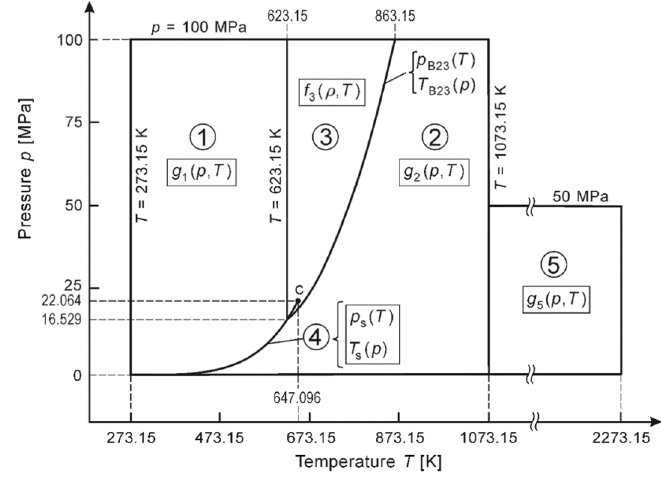
Figure 1. Regions and equations of IAPWS-IF97 [26].